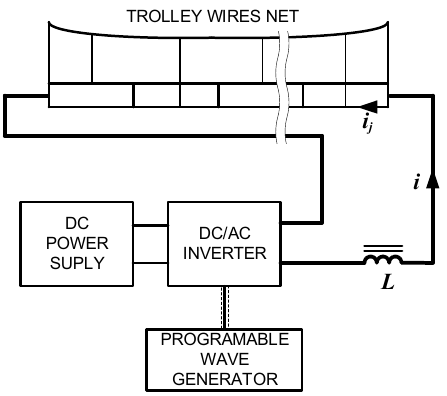
Figure 7. Block diagram of the de-icing system.